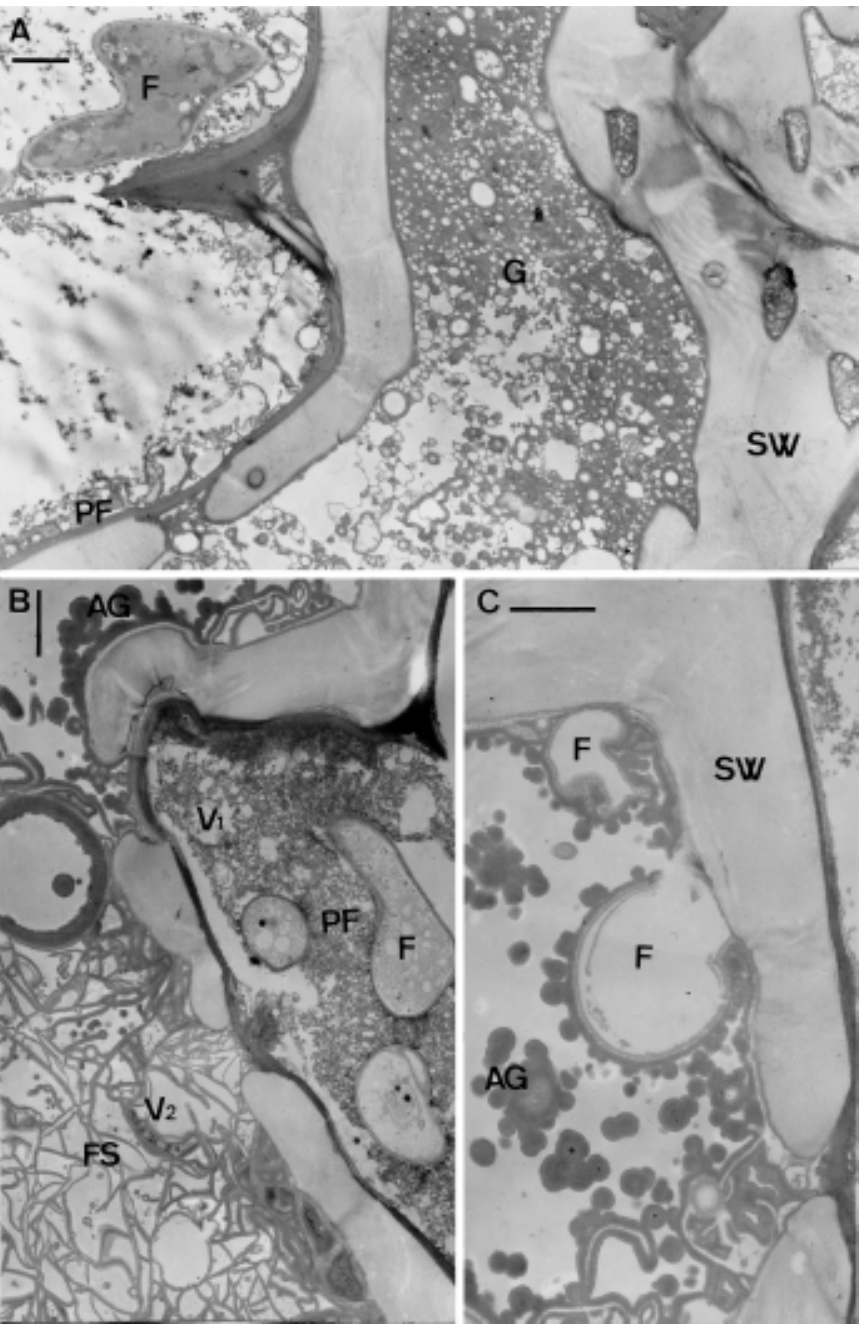
Fig. 6. TEM sections of vascular tissues of potato 7 days after bacterization with Bacillus cereus X16 and challenge with Fusarium roseum var. sambucinum . (A) Densely packed globules in potato vessels; (B) vessel lumina occluded by polymerized polymorphic flecks in V1 and by filamentous densely stained structures and amorphous osmiophilic aggregates in V2; (C) aggregates apparently responsible for damage caused to dead fungal hyphae in the vessel lumen. Bar = 2 mm. AG, aggregates; F, fungus; FS, filamentous structures; G, globules; PF, polymorphic flecks; SW, secondary wall; V,